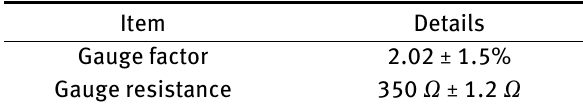
Table 2: Technical specifications of the strain